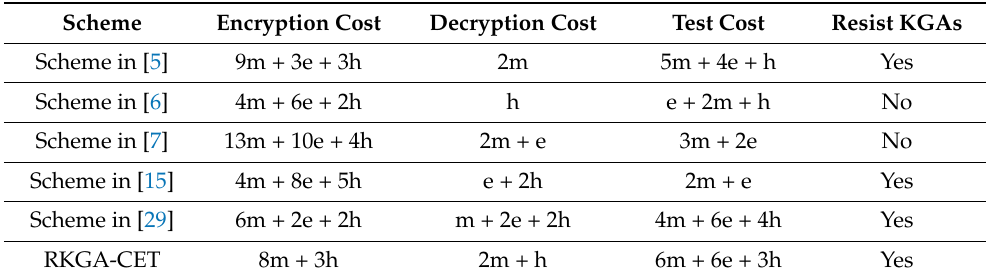
Table 1. Computational overhead and security